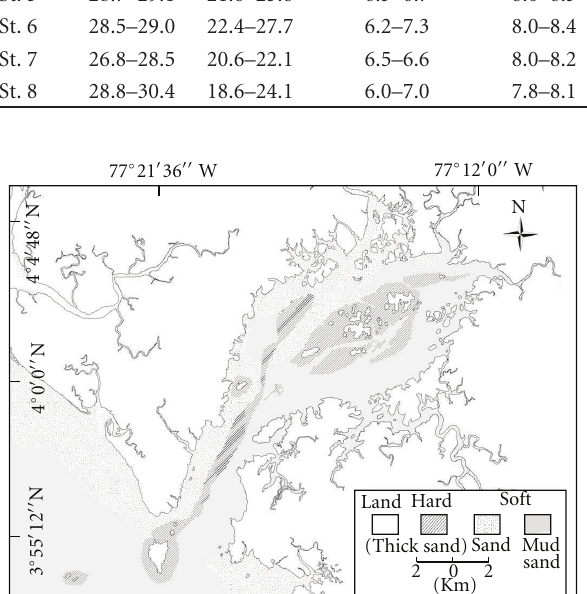
Figure 2: Distribution of substrate types in submerged bottoms of Bah´ıa Malaga